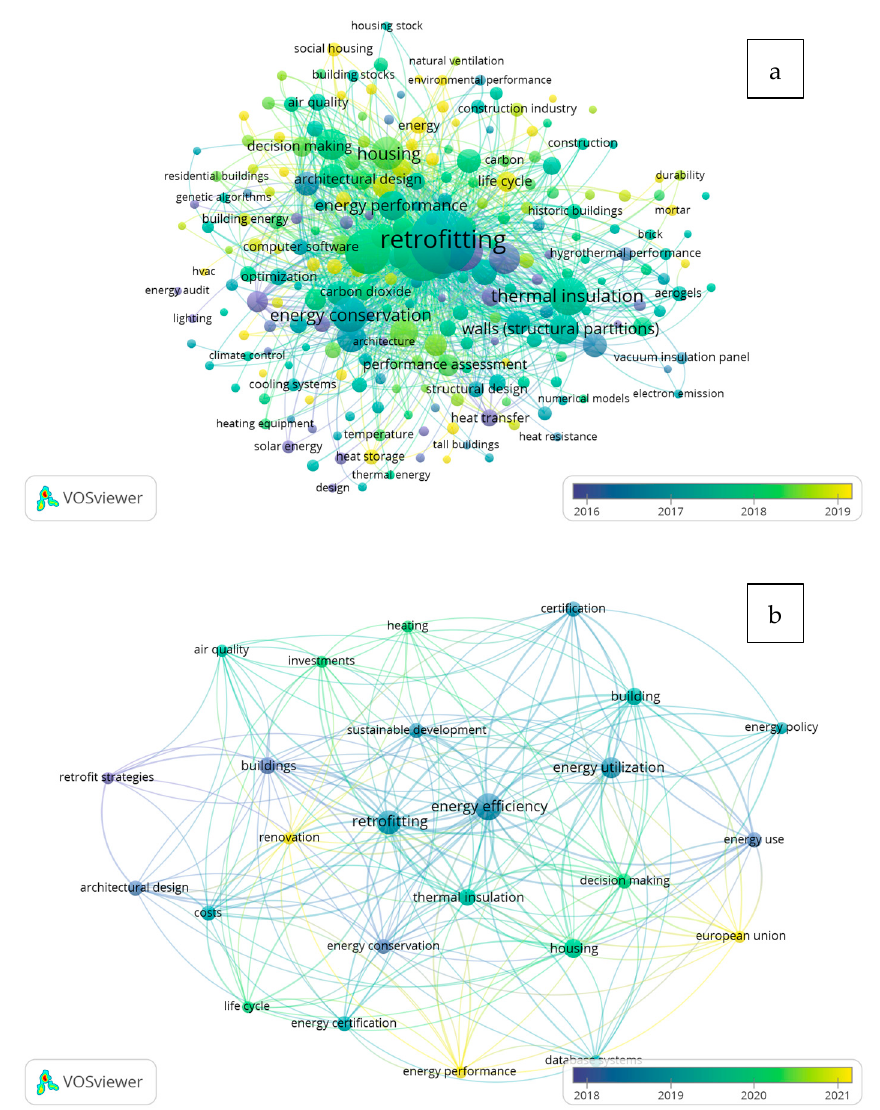
Figure 1. Global overview of the keywords used on buildings retrofitting ( a ) and certification of retrofitted buildings ( b ).